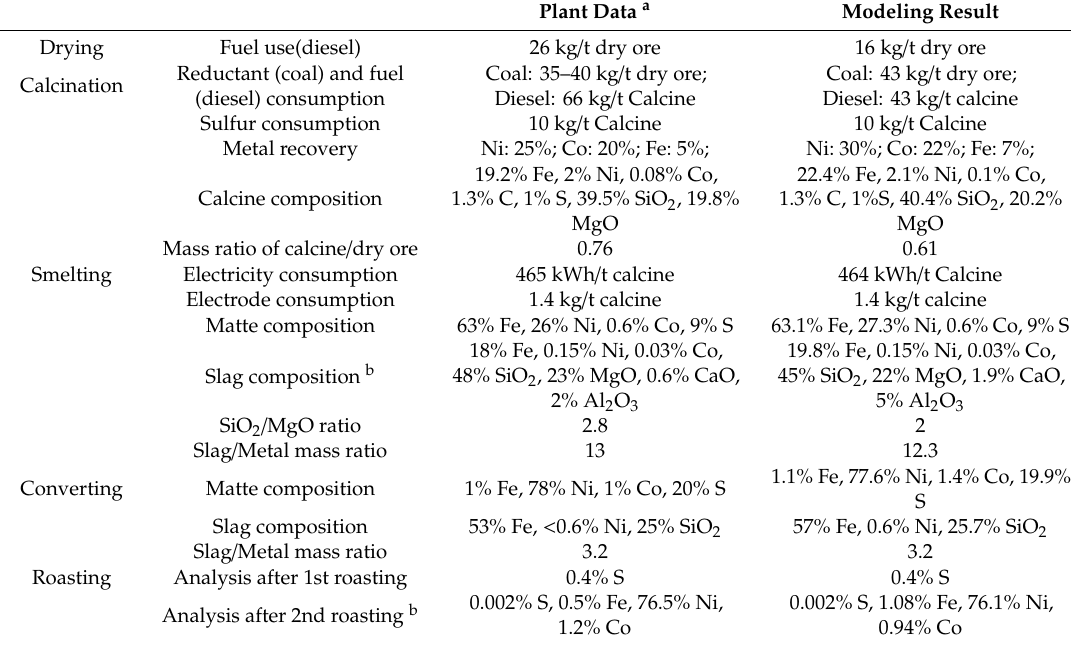
Table 9. Comparison of modelling result with plant value for Case